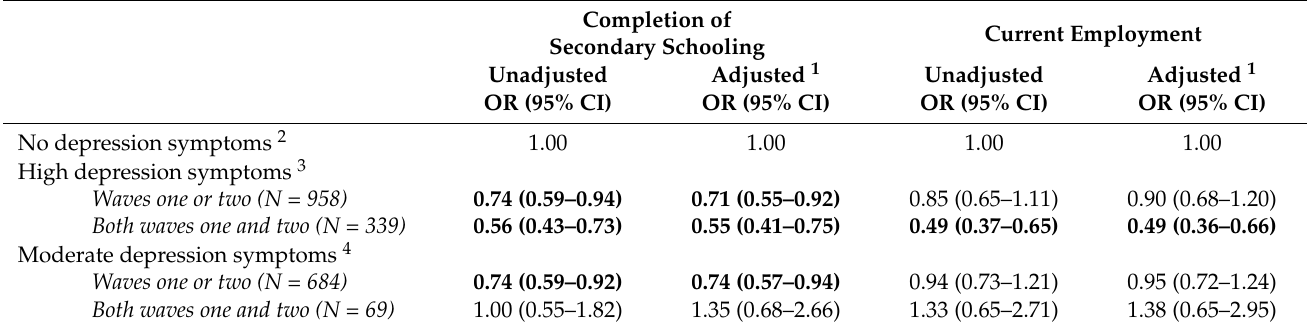
Table 2. Prospective associations between symptoms of depression and educational and employment outcomes at wave